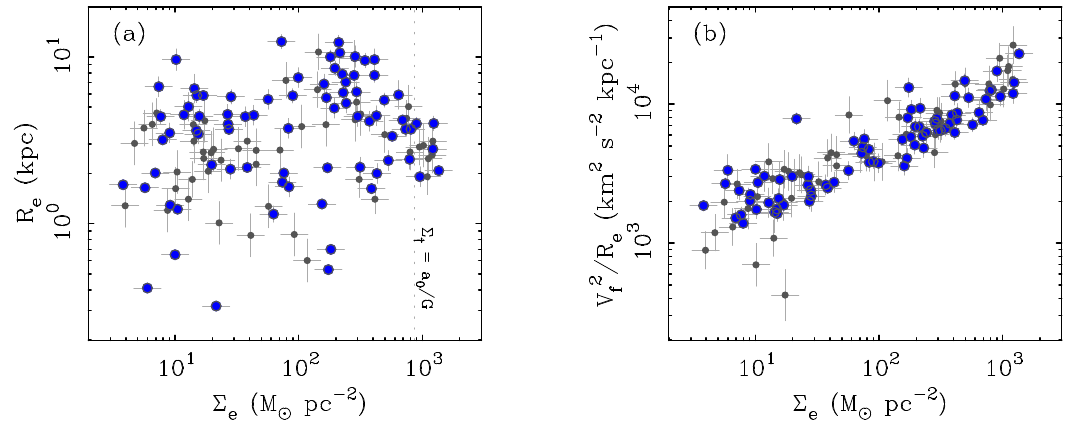
Figure 4. The effective stellar mass surface density of galaxies [29] as functions of their ( a ) effective radii and ( b ) characteristic accelerations. A galaxy must have a rotation curve that is extended enough to measure V f [42] to appear in this diagram. Larger points are galaxies with distances that are accurate to better than 20%; smaller points have less accurate distances. Effective surface brightness is converted to a surface mass density assuming a [3.6] Υ ∗ = 0.5 M (cid:12) /L (cid:12) . Galaxies exist over a wide range in size and surface brightness, with no particular correlation, up to a practical maximum in each ( a ). In contrast, there is a strong correlation between the characteristic acceleration and surface brightness ( b ), as anticipated by MOND. The scale Σ † = a 0 / G is noted as a dotted line in ( a ). Was the prediction made a